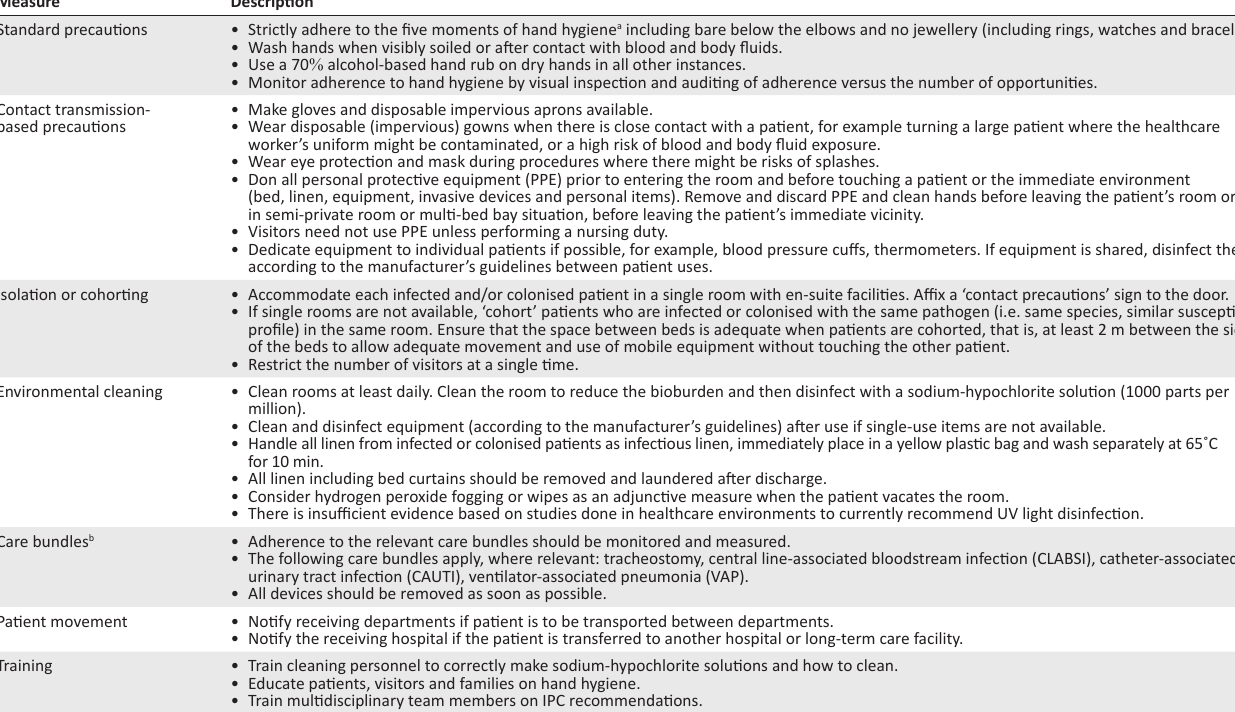
TABLE 4: Summary of recommendations for the prevention of transmission of Candida